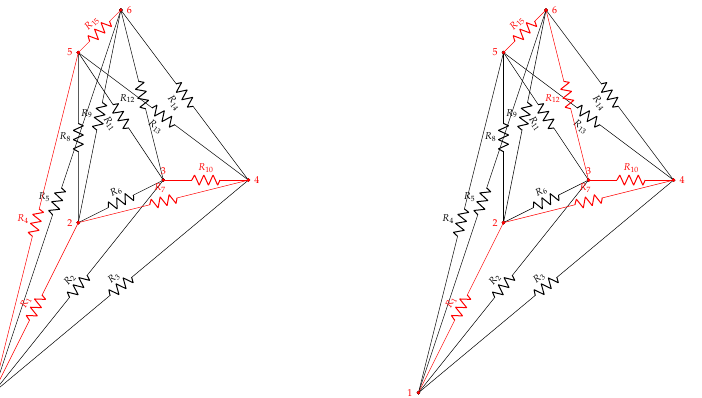
Figure 16. Path for delivering merchandise on the Xalapa map using different starting nodes. With the same purpose as in the city of Puebla, the information in Table 7 shows that, as the number of customers increases, the computation time remains constant in most of the range of variation. The maximum computation time reached is 46.87 ms. Table 7. Performance of CPU-time for different amounts of customers in the Xalapa map. Number of